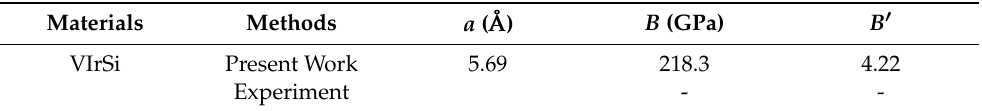
Figure 2. Electronic band structure and projected density of state of VIrSi. Table 1. Optimization of lattice parameter a , bulk modulus B , and pressure derivative of bulk modulus B (cid:48) of